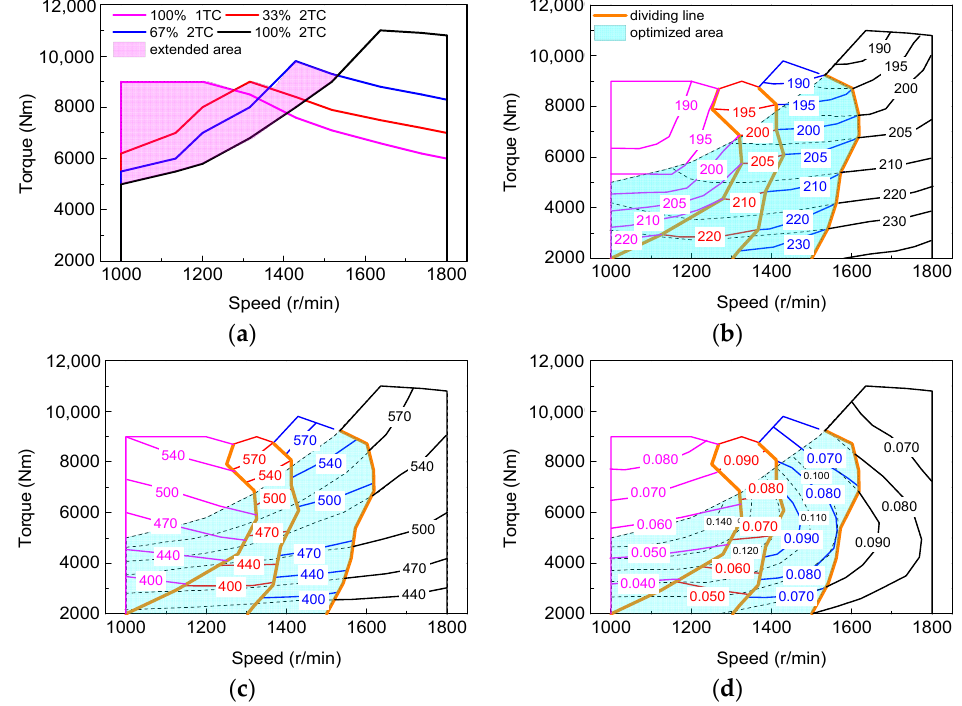
Figure 10. Matching characteristics of the compound VGT-STC system. ( a ) extended area. ( b ) contour of the BSFC. ( c ) contour of the exhaust temperature. ( d ) contour of the smoke opacity.